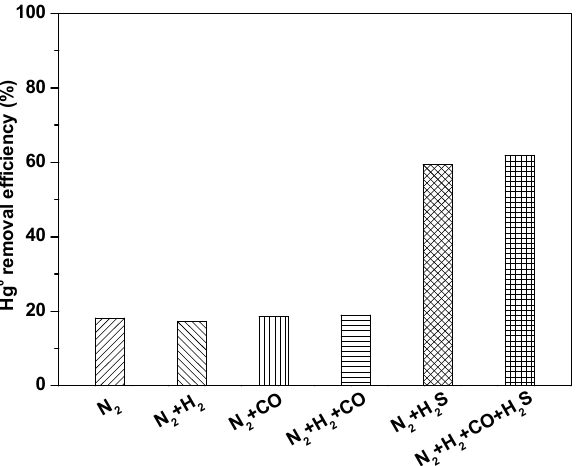
Figure 6. Effect of syngas components on Hg 0 removal by Fe 2 O 3 /AC. (Reaction condition: C Hg0 = 80 μ g/m 3 , GHSV = 15000 h − 1 , T = 150 °C.)